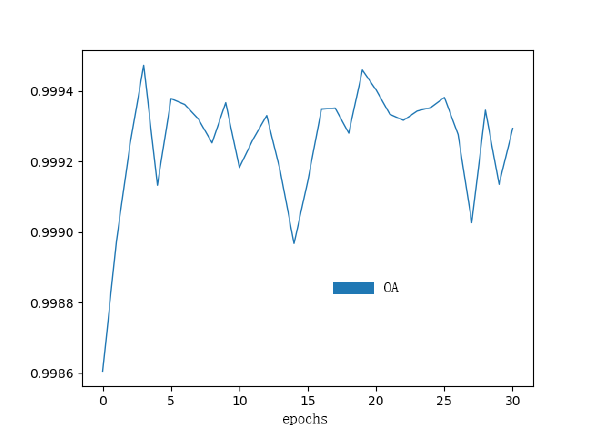
Figure 5. Overall accuracy in training epochs.